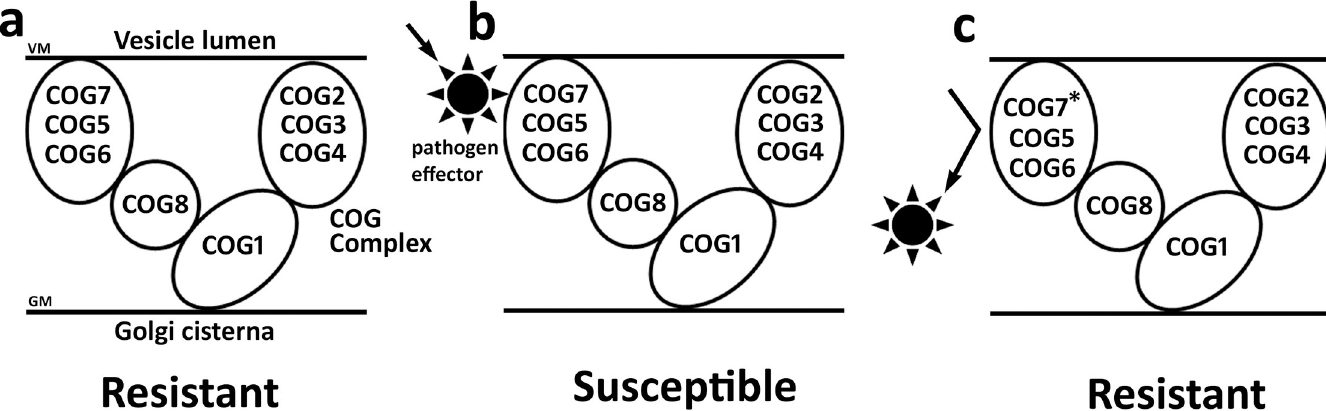
Fig 5. Model. A. The COG complex functions in defense. B . A pathogen effector alters the functionality of the COG complex, leading to susceptibility. C . The COG complex composition becomes altered with a splice variant (COG7-2-b � , Glyma.12G013000.2) which alters the ability of the pathogen effector to bind, restoring the ability of the COG complex to function in defense, leading to a resistant reaction. VM, vesicle membrane; GM, Golgi membrane. The position of the COG proteins in relation to the Golgi and vesicle membranes does not imply specific interactions.